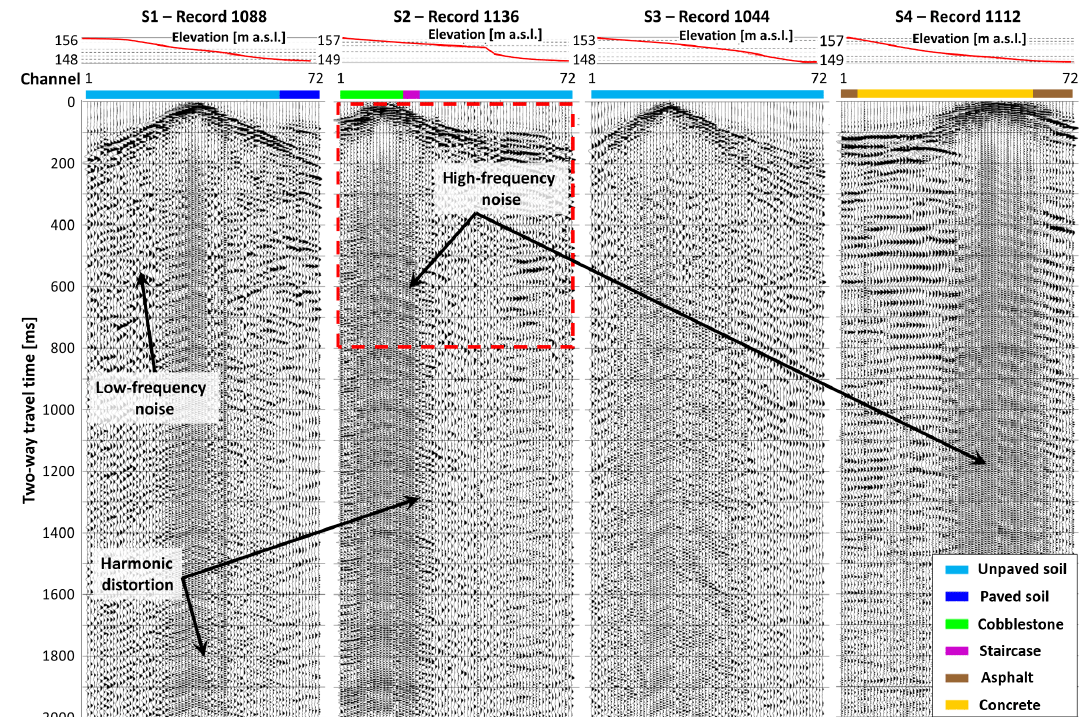
Figure 7. Comparison of records of the four SH-wave seismic profiles showing the differing data quality, despite the four profiles not being far away from each other (cf. Fig. 4). The processing steps applied to the data are vibroseis correlation, an AGC, a bandpass filter around the sweep frequency range, and amplitude normalization. The main controlling factor is near source inhomogeneities in the subsurface leading to harmonic distortions, which cover the reflection signals by high-frequency noise. Also the coupling quality on unpaved soil or cobblestone is impaired compared to a paved surface e.g., an asphalt- or concrete-paved road. Besides the harmonic distortions, low- and high-frequency noise caused by environmental noise also drown out the reflection signals, especially on profiles S1, S2, and